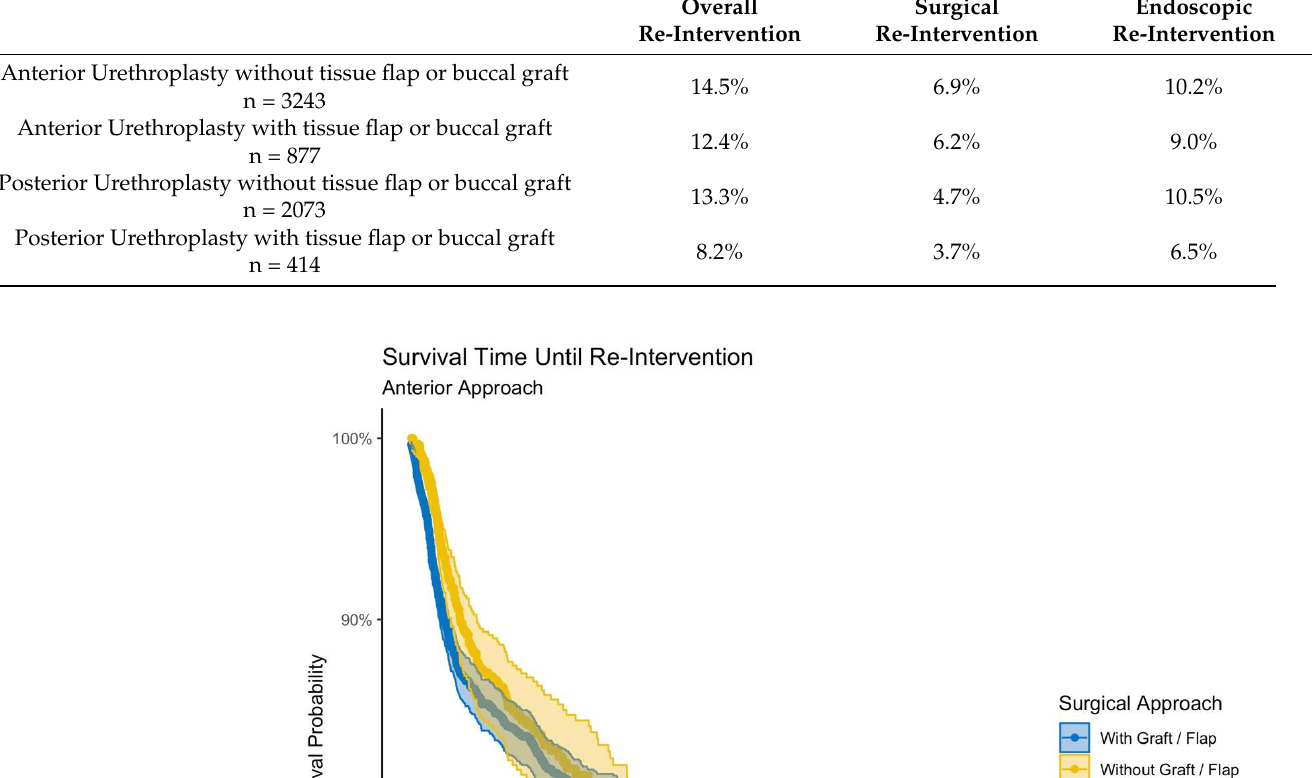
Table 1. Rates of secondary procedures performed after index urethroplasty. Overall